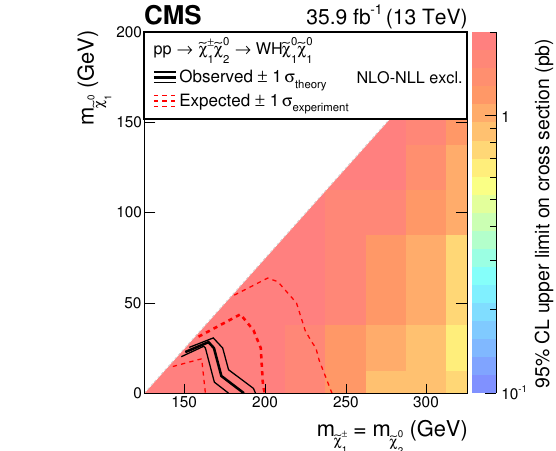
(right) model obtained with events of all categories (SS 1